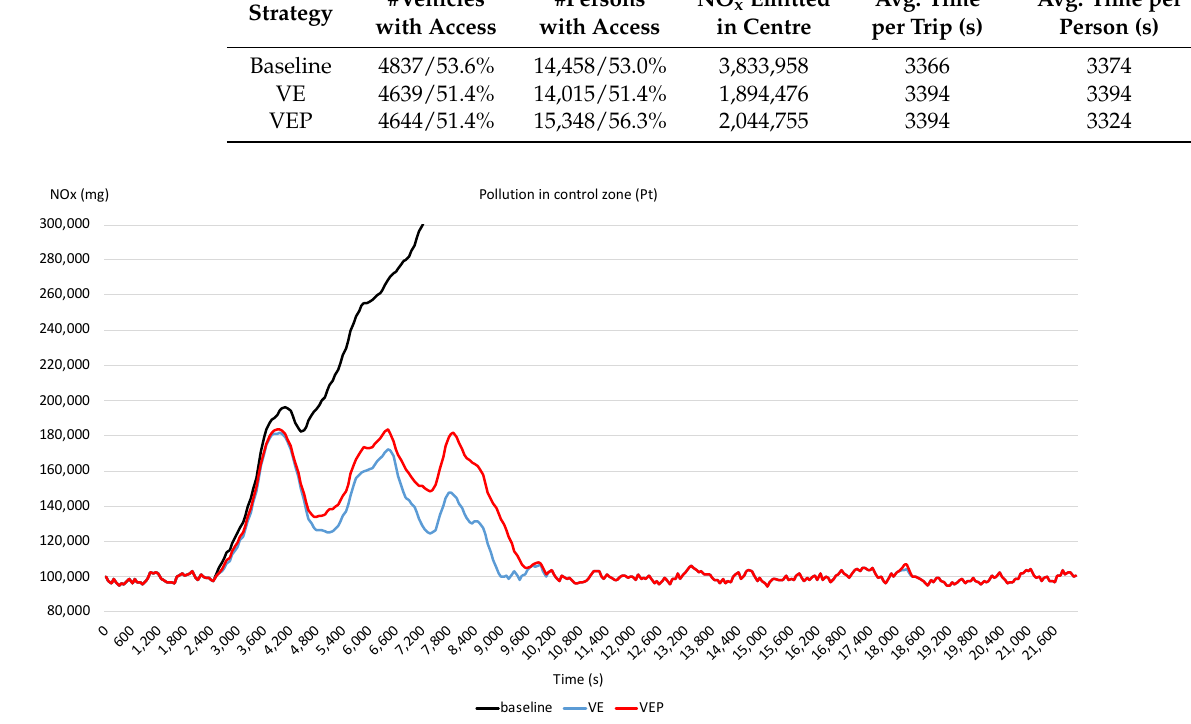
Figure 3. Evolution of the pollution (NO x ) in the control zone during the simulation for parking access with varying arrival rates.